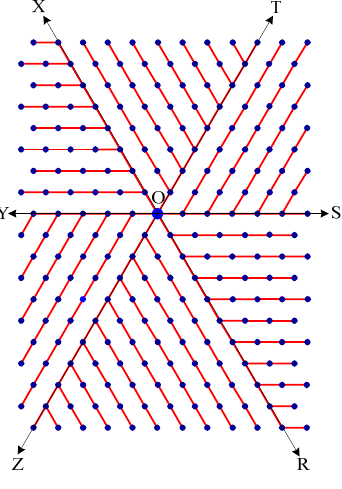
Figure 12. Broadcasting tree of boron nanotube. Broadcasting is based on farthest- distance-first